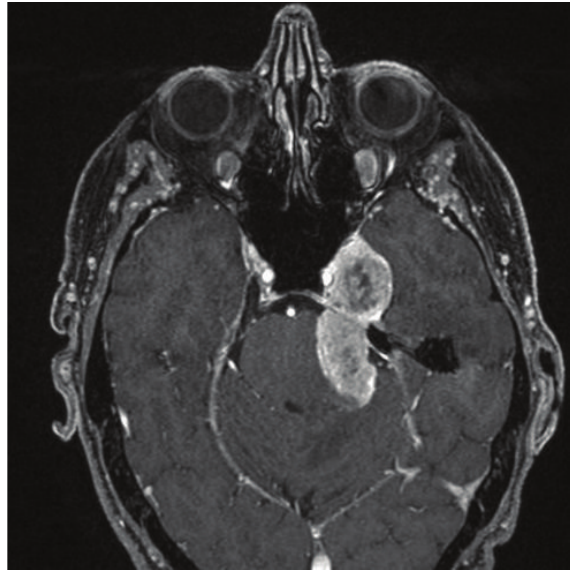
Figure 1: T1 Axial Fat Saturated, Gadolinium enhanced MRI scan of the head. This image displays the case of a 48-year-old man with a previous excision of a neurotropic melanoma of the face. Approximately one year from wide local excision he presented with facial pain and biopsy proven recurrence of neurotropic melanoma involving the mandibular division of the trigeminal nerve, filling the cavernous sinus and prepontine cistern with obvious brainstem compression.